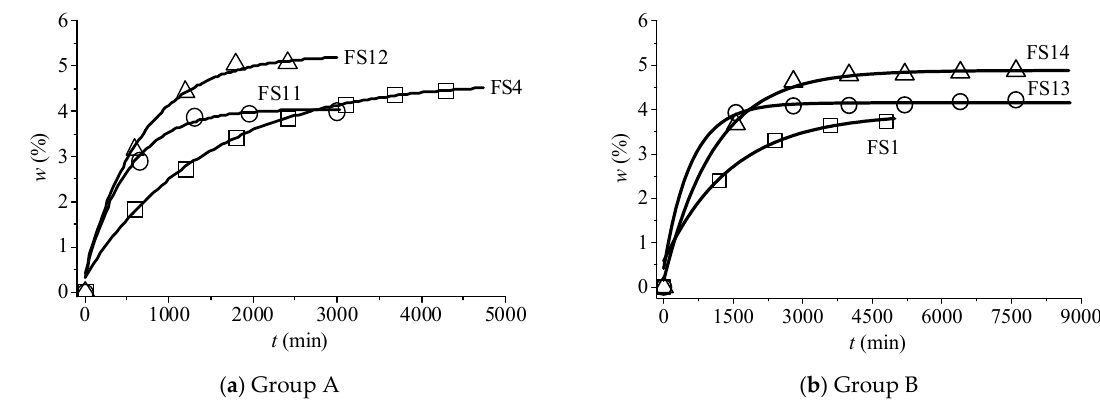
Figure 7. Relationship between water imbibition and time.